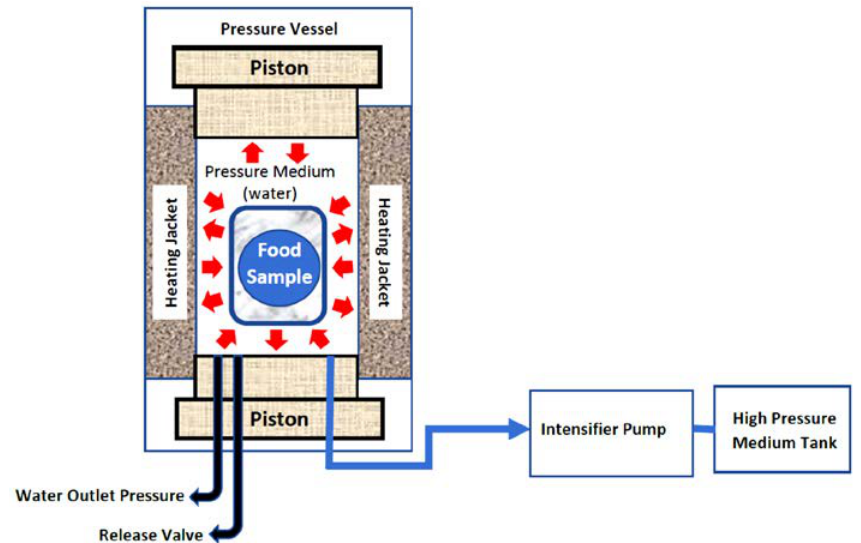
Figure 4. Diagram of high-pressure processing (HPP).